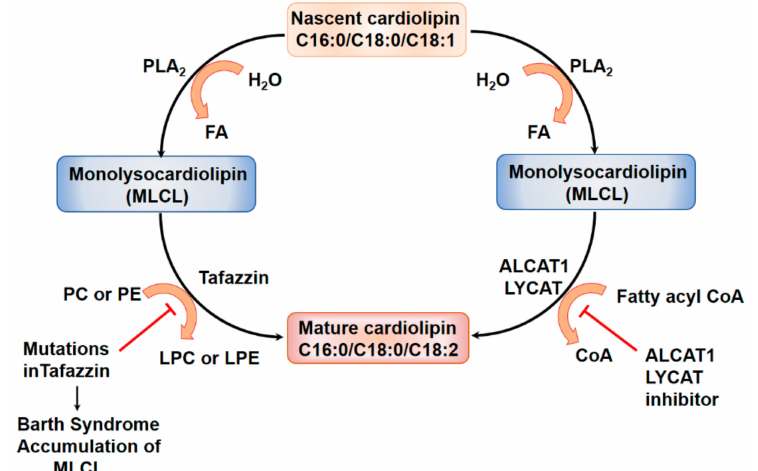
Cardiolipin remodeling by lysocardiolipin acyltransferase in pulmonary